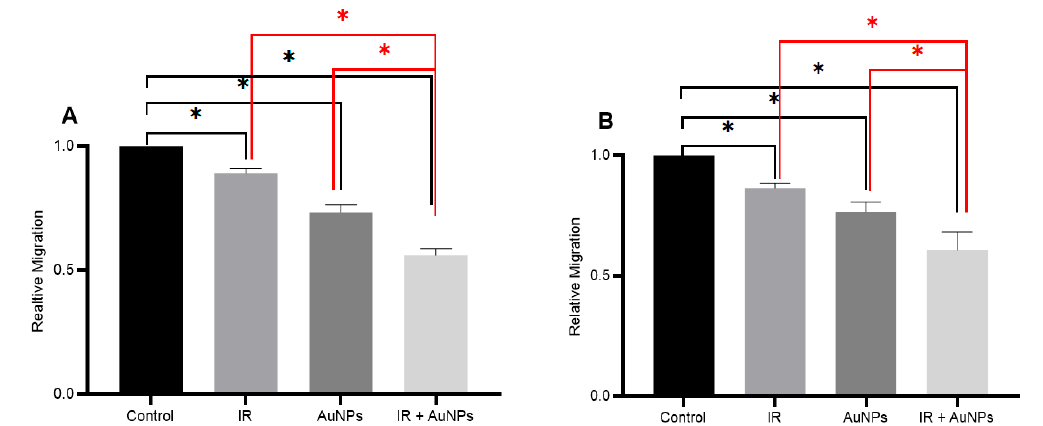
Figure 6. The e ff ect of IR and / or AuNPs on human cancer cell migration in vitro. Relative cell migration of ( A ) DU145 (prostate) and, ( B ) A549 (lung) cancer cells. Control represents untreated cells, IR: cells irradiated with 5 Gy X-ray, AuNPs: cells treated with 1 mM AuNPs, and IR + AuNPs: cells were treated with both 5 Gy X-ray and 1 mM AuNPs. Results expressed as the mean ± SEM of 3 replicates. Significance of di ff erent treatments compared to control is represented by black lines, and between treatments is represented by red lines is shown as * p < 0.05.